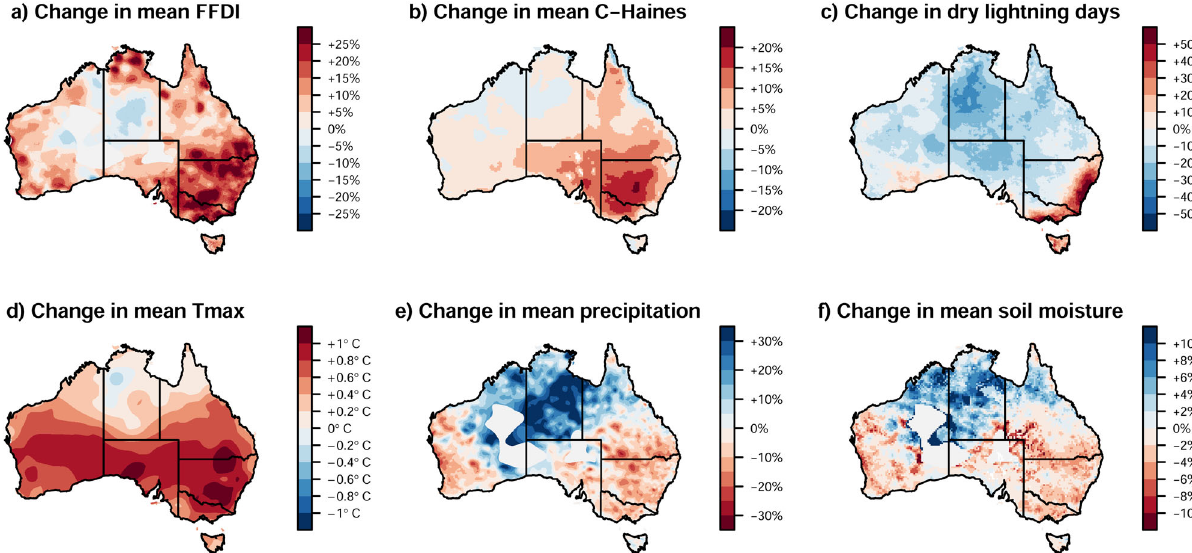
Fig. 5 Climate change factors associated with wild fi re weather and activity. a Near-surface fi re weather conditions based on the Forest Fire Danger Index, ( b ) mid-tropospheric fi re weather conditions based on the C-Haines Index, ( c ) dry lightning conditions as key factors for ignitions, ( d ) daily maximum temperature, ( e ) annual rainfall de fi cit and ( f ) soil moisture (0 – 23 cm) associated with dryness of the forest system. Changes are calculated as the changes from 1980 – 1999 to 2000 – 2019, calendar years, for all variables except for dry lightning to 2000 – 2016. Grey areas in ( e ) and ( f ) denote areas with insuf fi cient data